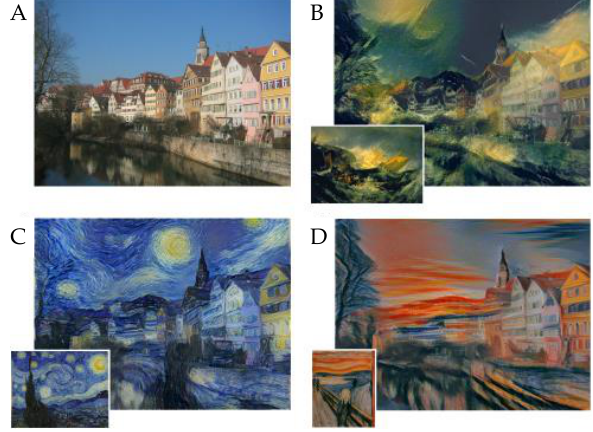
Figure 3. Examples of style transfer method, ( A ) is content images, ( B – D ) are style-transferred examples, and the corresponding style images are in left bottom of three examples.